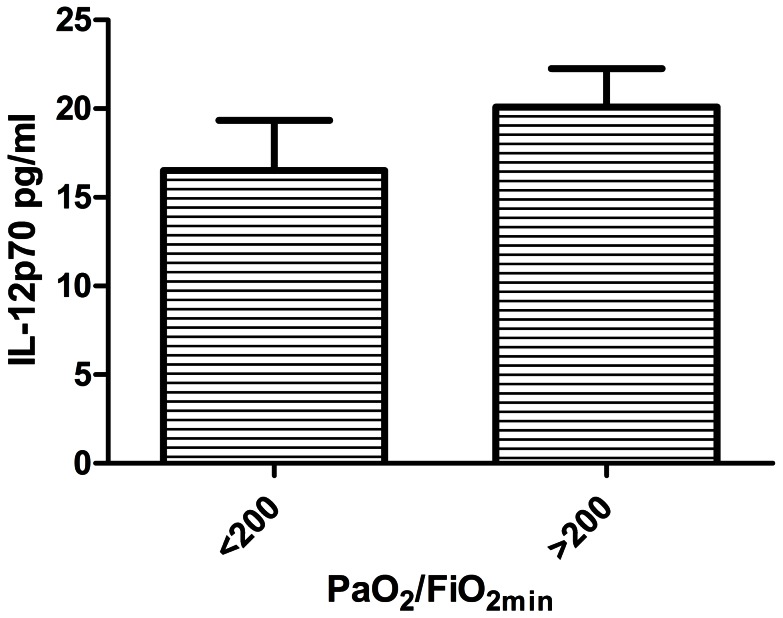
Comparison of averaged early (<72 hr post injury) IL-12p70 concentrations in mainstem bronchial washings, between the lowest PaO2/FiO2 ratios during the first 2 weeks post injury (PaO2/FiO2) of <200 (N = 16), and patients with PaO2/FiO2 ≥200 (N = 24).Bars represent mean ± SE.